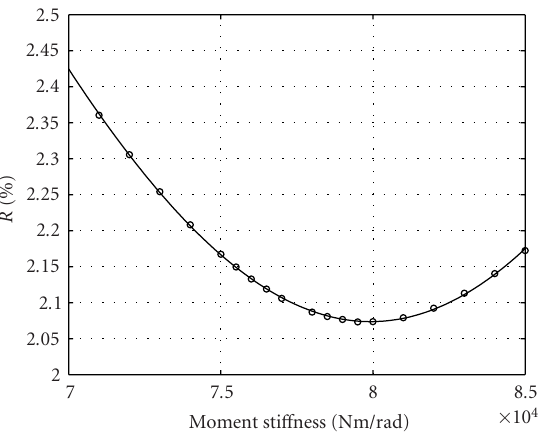
Figure 22: Minimization of the residue R for the configuration B .